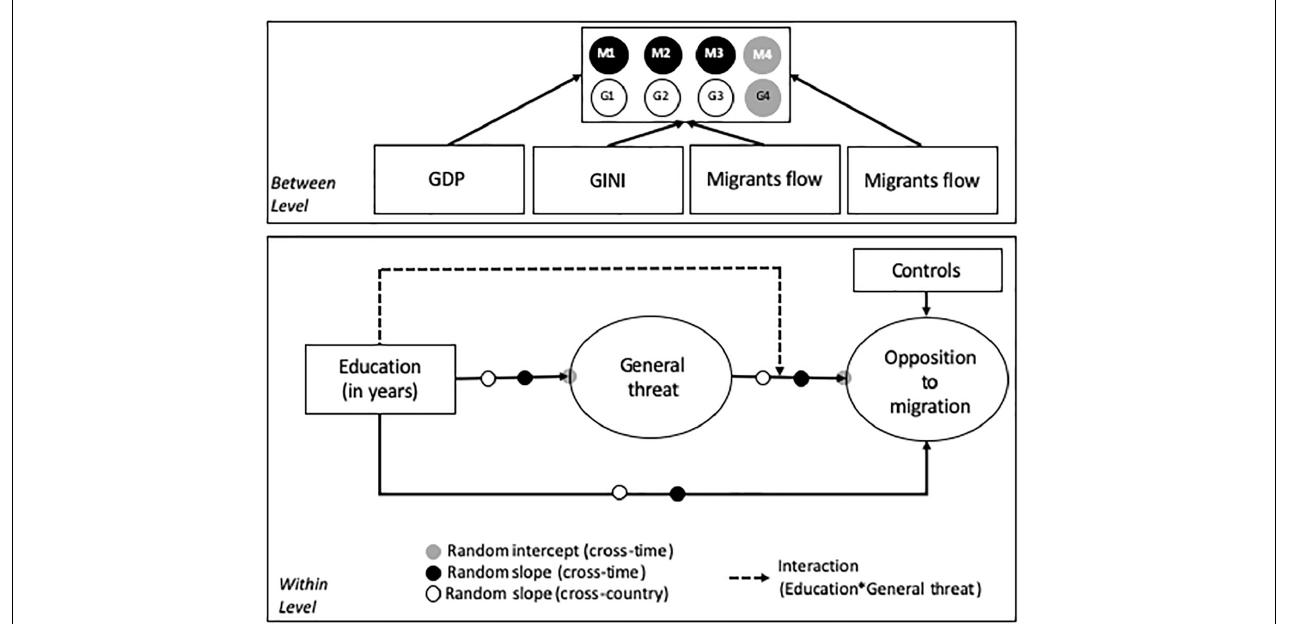
FIGURE 1 | Theoretical mediation model of the association between education and opposition to migration.